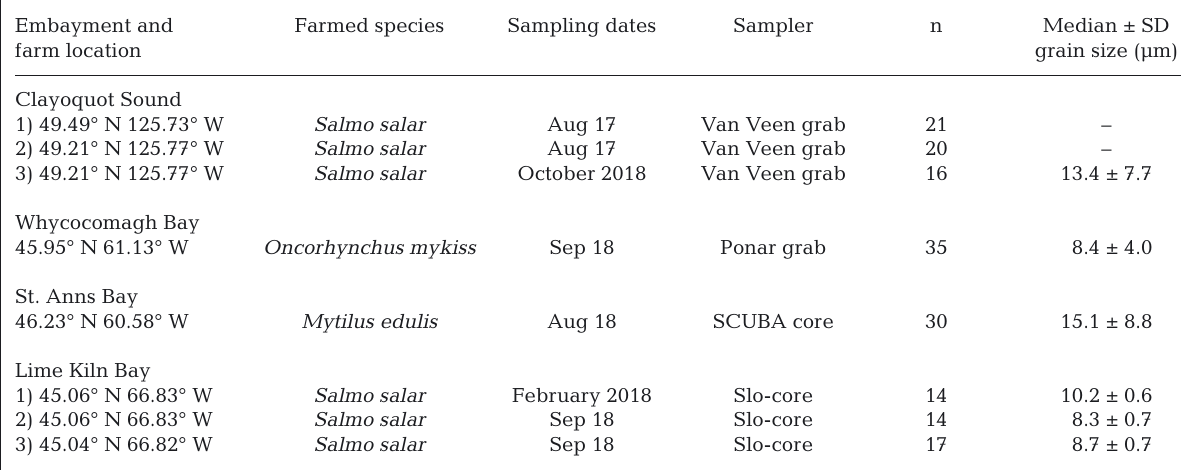
Table 2. Sampling details at fish and shellfish aquaculture farms used to study potential geographic biases in total free sulfide measurements. These sites are in addition to the 3 bays described in Table 1